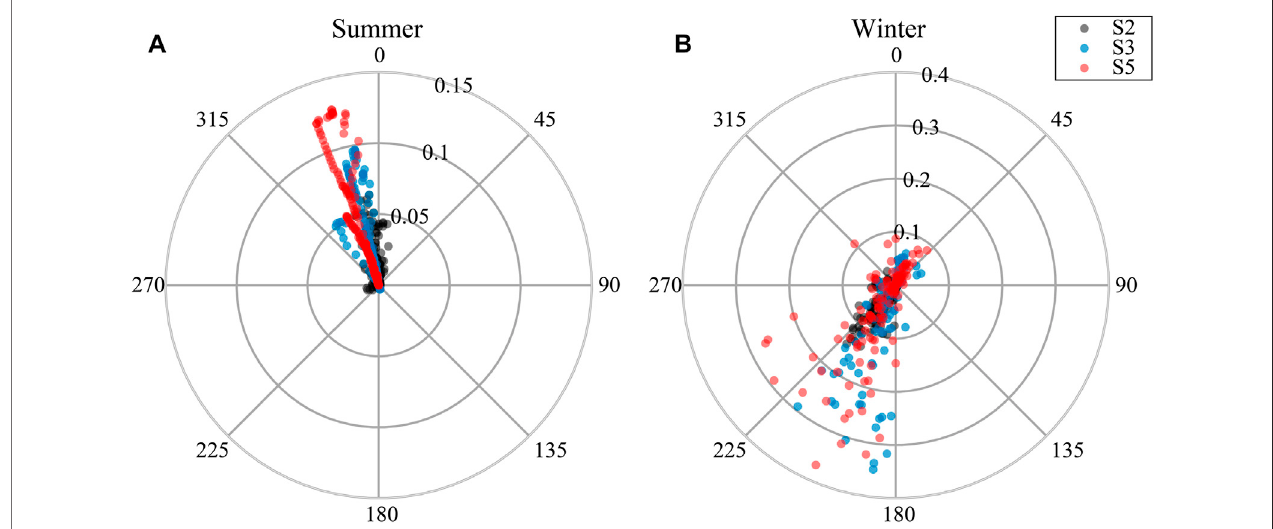
FIGURE 4 | Wave magnitude and direction for three stations (S2, S3, and S5) in (A) summer and (B) winter, with 0 ° corresponding to the northward propagating wave, and the radial axis representing the bottom wave-orbital velocity, u b , in m/s.